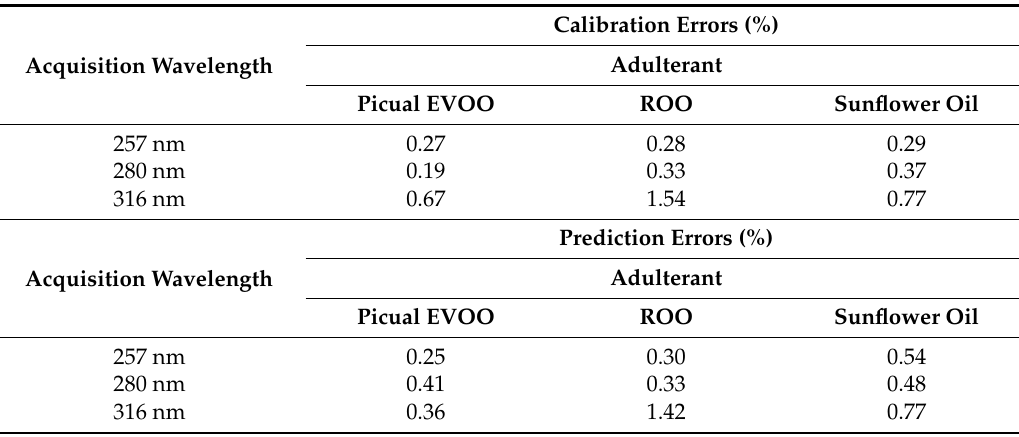
Figure 4. Partial least square (PLS) regression results for the adulteration of an Arbequina monovarietal EVOO using a Picual monovarietal EVOO, a ROO, and a sunflower oil as adulterants. Data set: raw HPLC-UV chromatographic fingerprints registered at 257 nm. ( a ) Estimation of the optimum number of latent variables; ( b ) validation results in the calibration step; and ( c ) validation results in the prediction step. RMSECV: root-mean-square errors in cross validation. Table 1. Partial least square (PLS) calibration and prediction errors in the identification and quantitation of adulterants (Picual EVOO (extra-virgin olive oil), refined olive oil (ROO), and sunflower oil) in an Arbequina EVOO when using raw HPLC-UV (High performance liquid chromatography method with ultra-violet detection) chromatographic fingerprints as sample